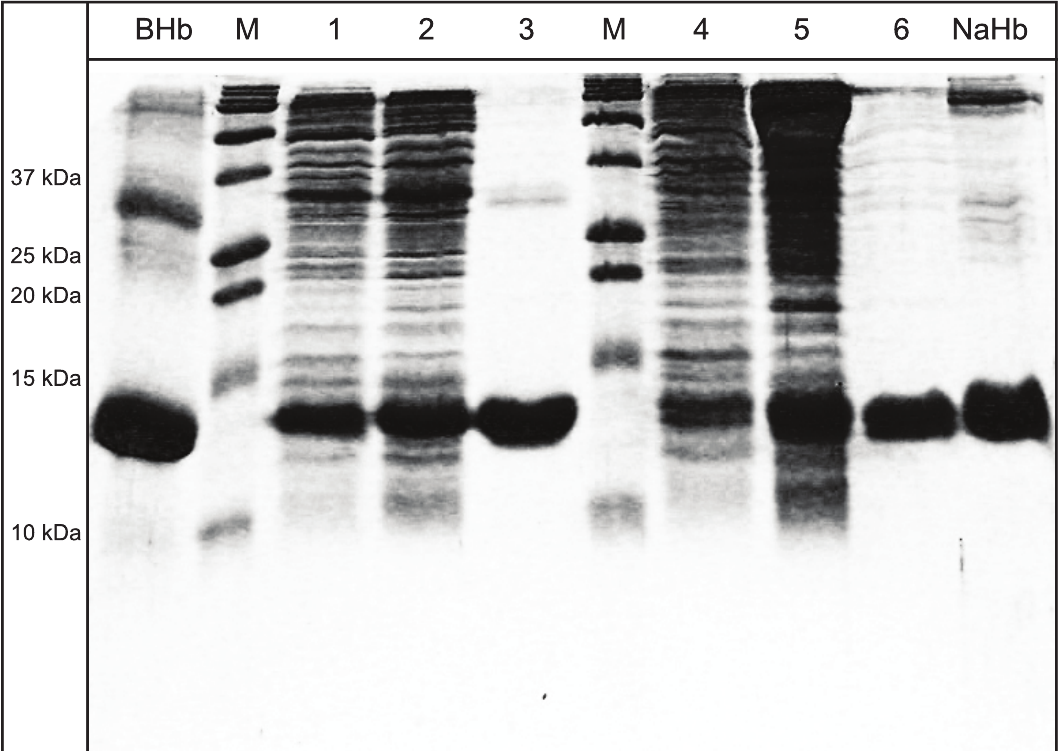
Figure 2. SDS-PAGE (20%) image showing the purified rHb isoforms. Lane BHb, Bovine Hb standard; Lane M, BioRad size standards; Lane 1, HH crude lysate; Lane 2, HH clarified fraction after dialysis; Lane 3, HH purified fraction; Lane 4, LL crude lysate; Lane 5, LL clarified fraction after dialysis; Lane 6, LL purified fraction; Lane NaHb, Native Hb from deer mouse blood.